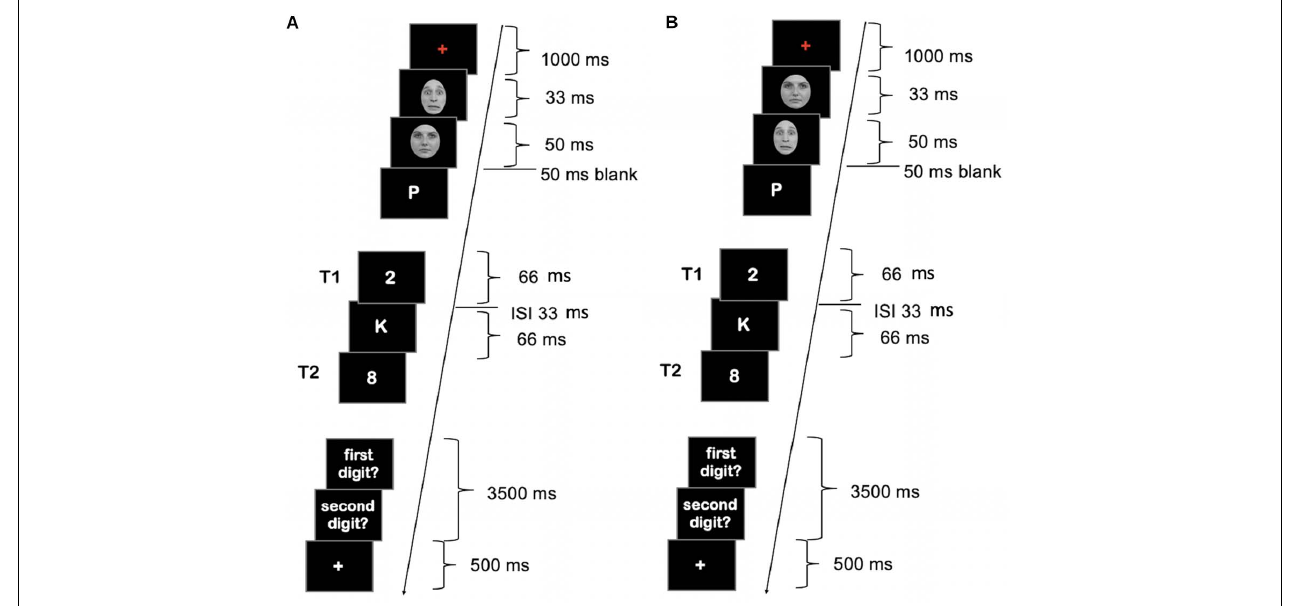
FIGURE 1 | Schematic illustration of the attentional blink (AB) stream in Experiment 1. (A) Masked condition. (B) Unmasked condition. Face images were obtained from the Radboud Faces Database (Langner et al., 2010) and are reprinted in line with the guidelines of the database.